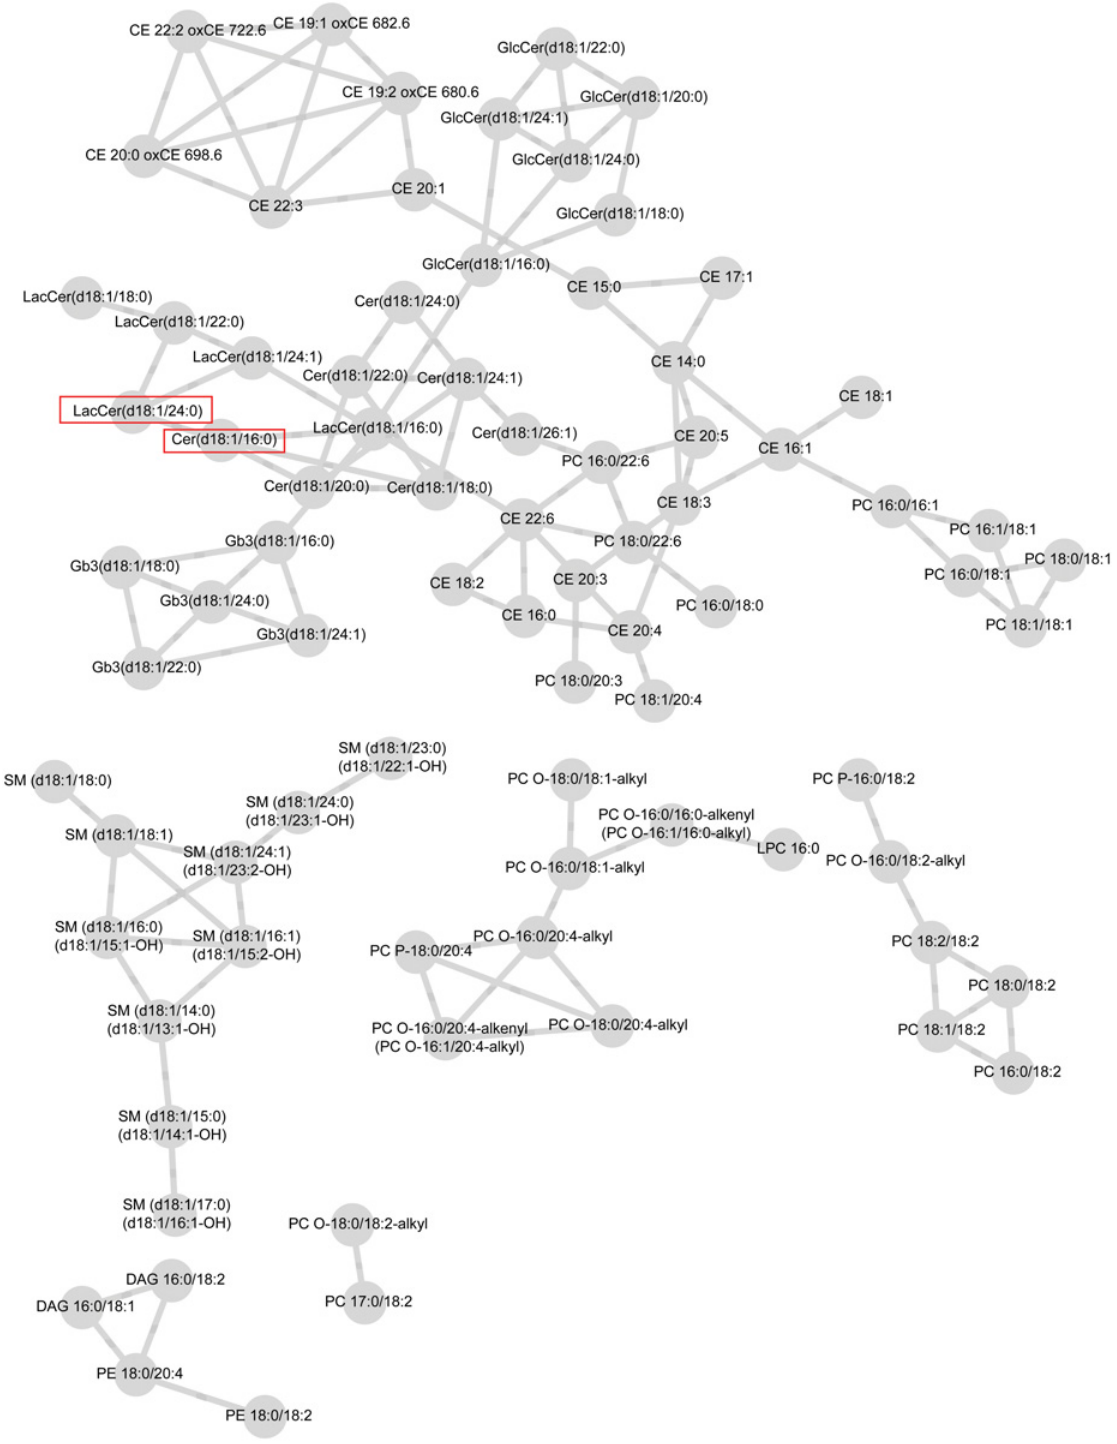
Fig 1. Lipid network for case-group with parameter values ε = 0.4 and minimum modular size = 3. Significant lipids from the test for differential connectivity of a single lipid are circulated. A module consisting of lipids belonging to the same lipid class is highlighted with rectangles as well.